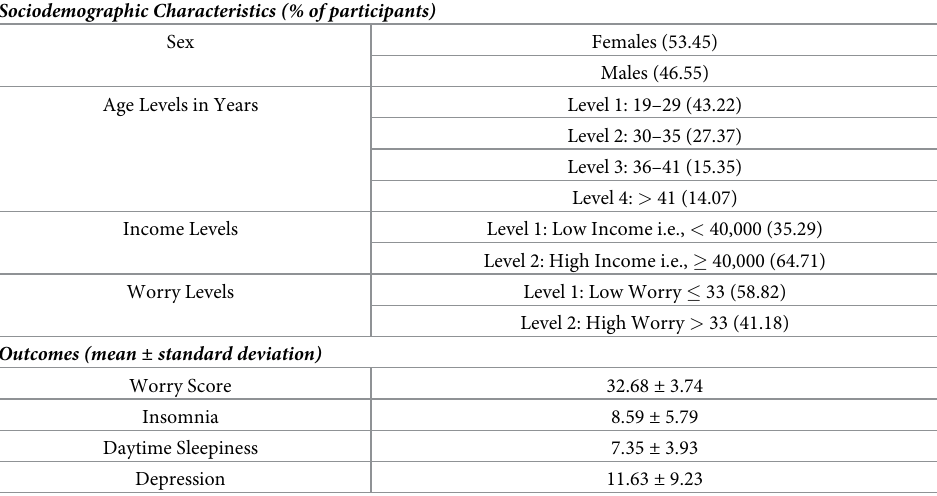
Table 2. Sociodemographic characteristics and measures of worry score, sleep, and severity of depressive symptoms. Sociodemographic Characteristics (% of